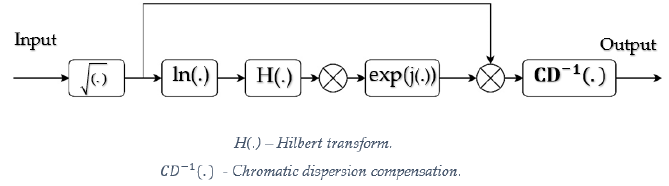
Figure 4. Schematic diagram of the KK receiver scheme.